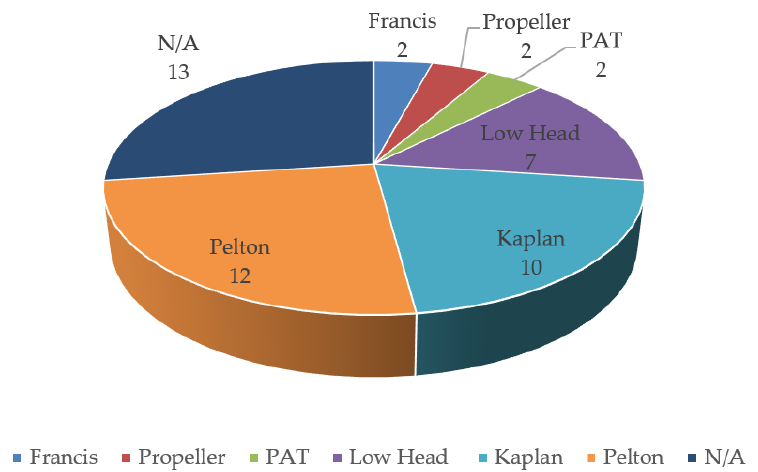
Figure 6. Hydraulic machinery types applied in case studies.